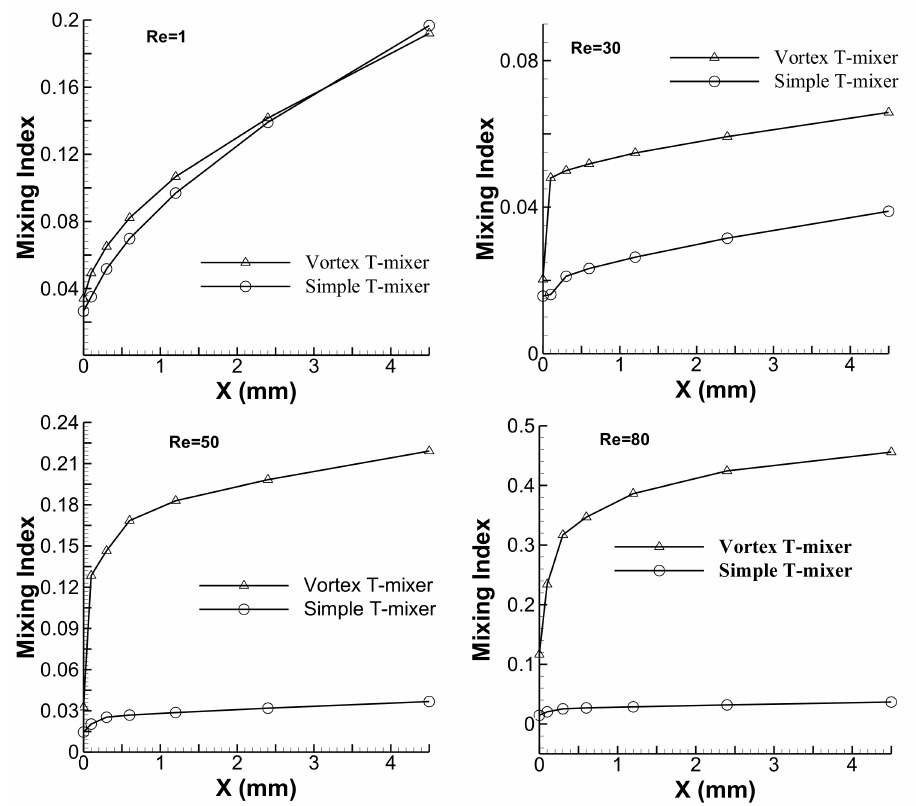
Figure 8. Numerical results for the development of the mixing index along the x -axis at various Reynolds numbers for simple and vortex T-mixers with the straight mixing